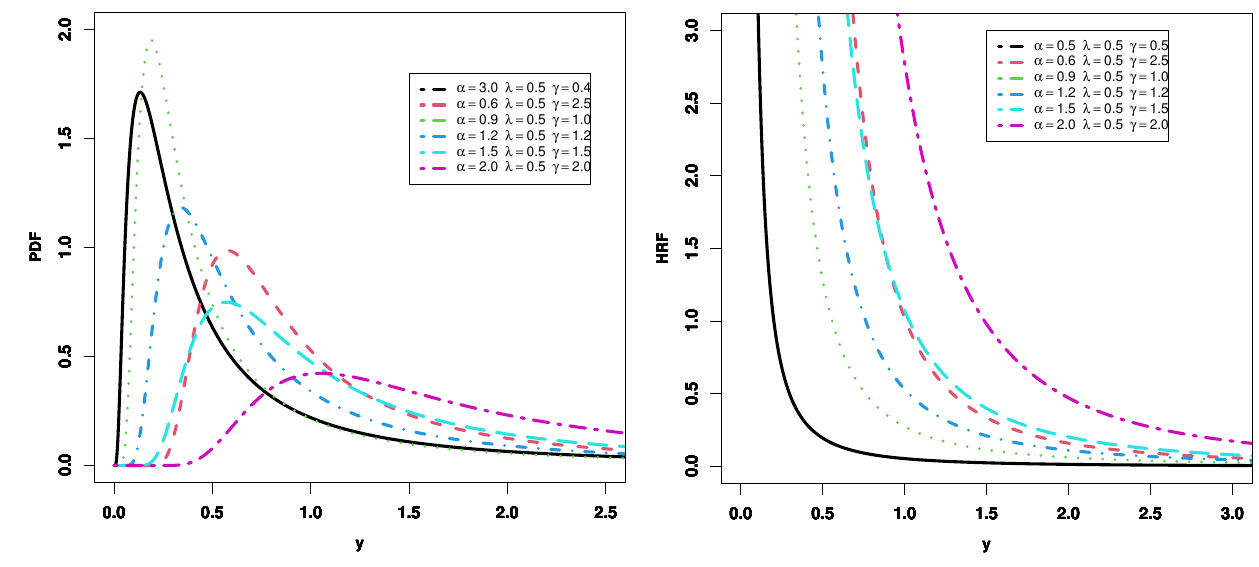
Figure 1. Curves of PDF and HRF for the HL-INH